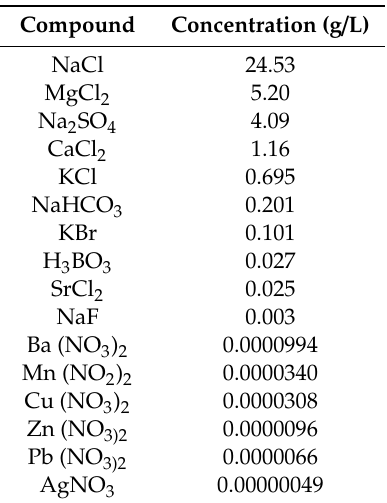
Table 5. Chemical composition of synthetic seawater employed in the tests.